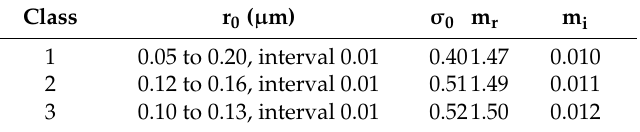
Table 2. Size distribution parameters of the fine-mode aerosols used in this study